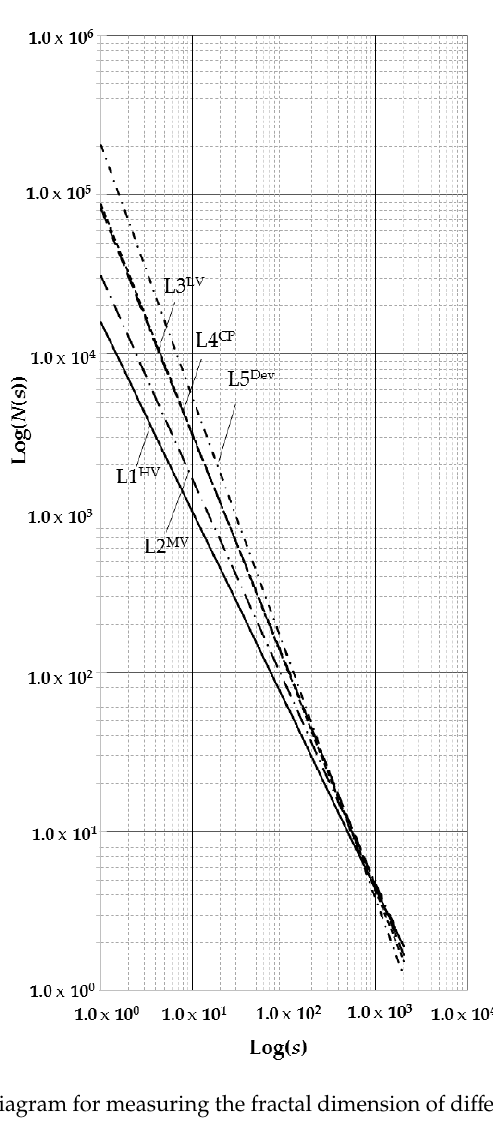
Figure 10. Logarithmic diagram for measuring the fractal dimension of different separate fractal levels.